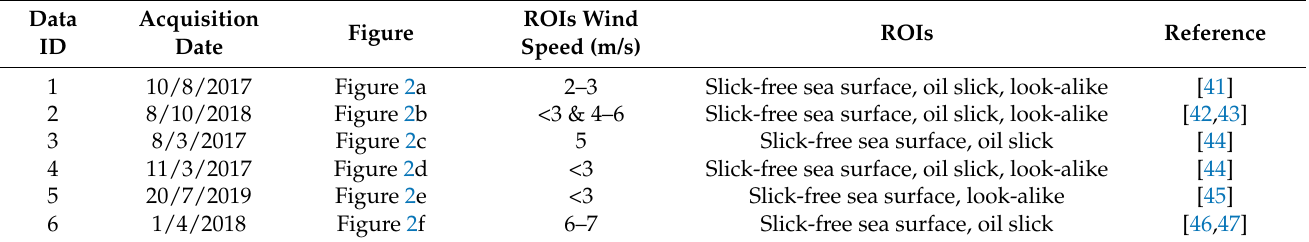
Table 1. Main features of the S1 SAR